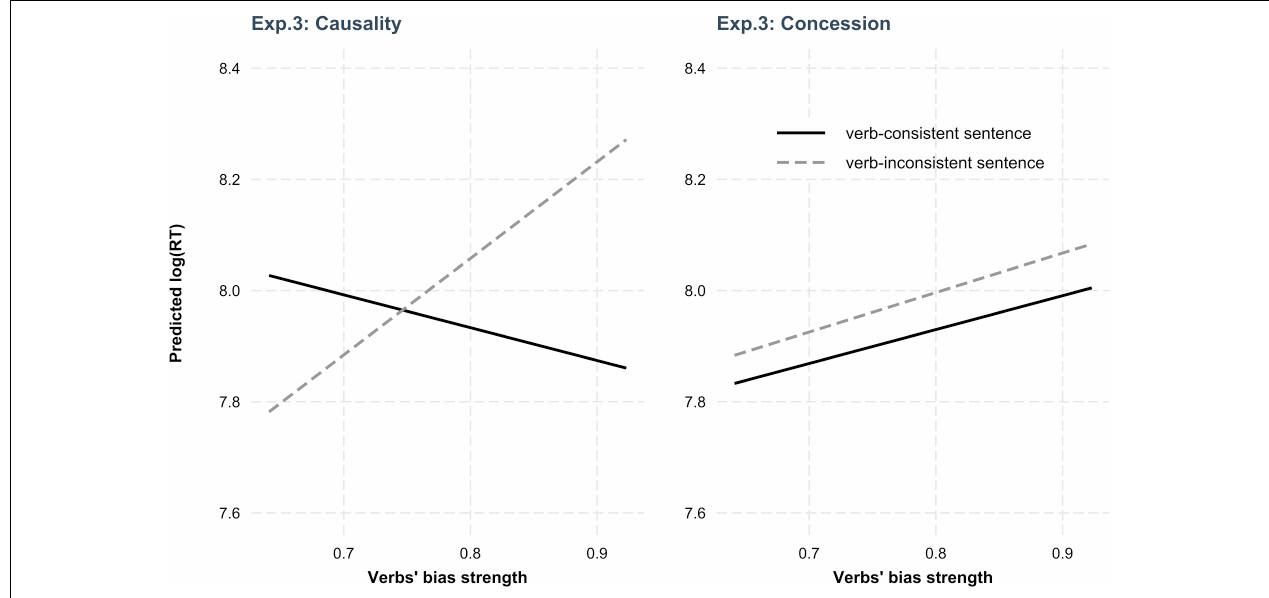
FIGURE 4 | Plot illustrating the three-way interaction among consistency , strength , and relation in Experiment